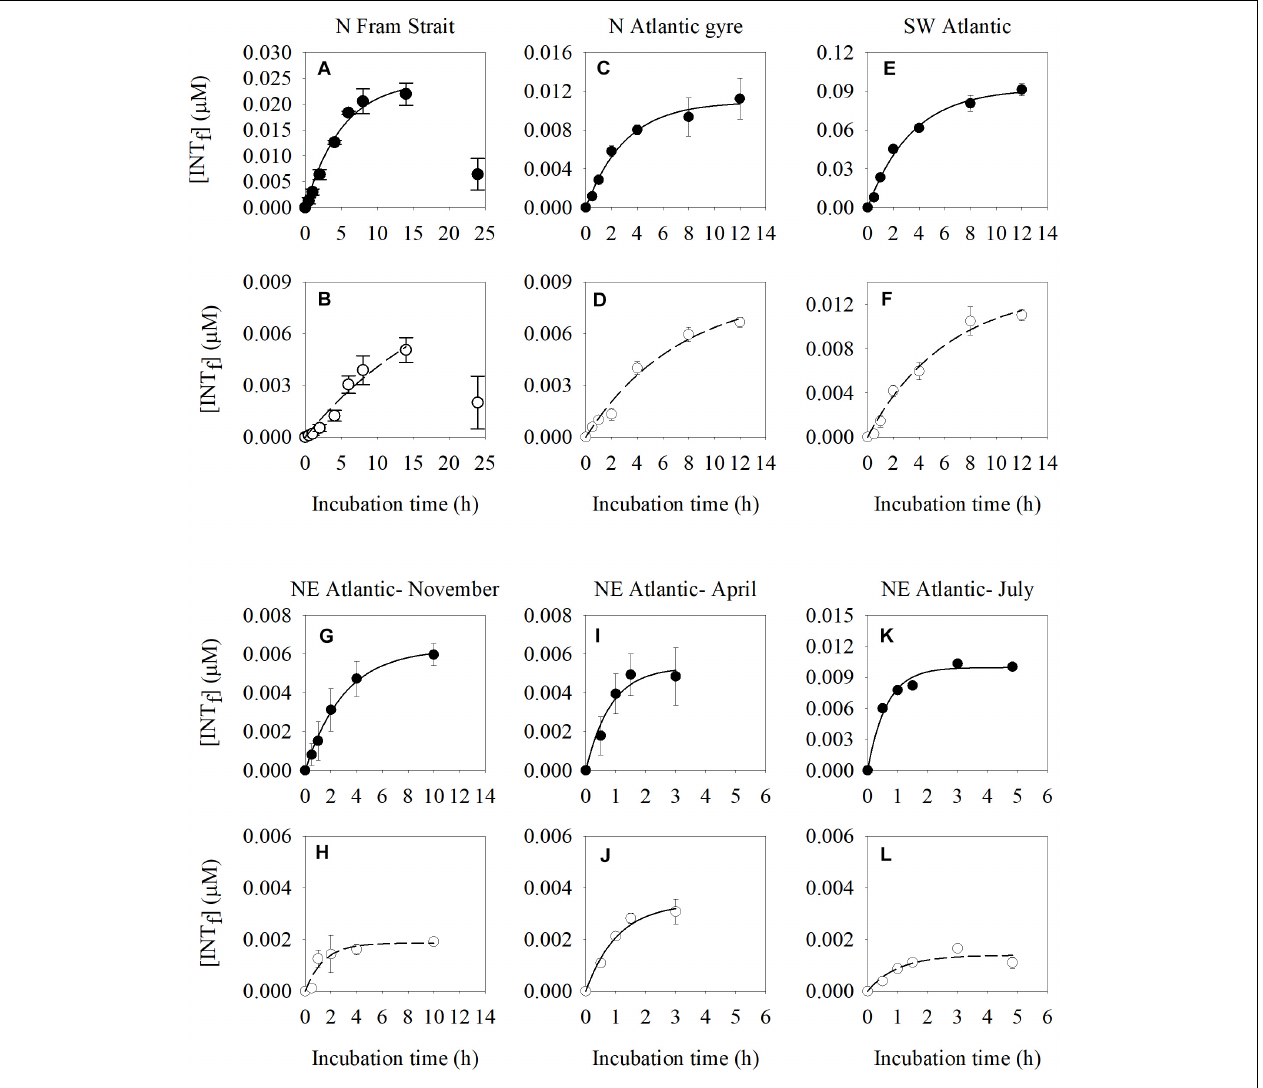
FIGURE 2 | Time course changes of INT formazan (INT f ) concentration ( µ M) produced by the reduction of INT of natural plankton communities estimated in two different size fractions: the > 0.8 µ m size-fraction (solid dots) (A,C,E,G,I,K) and 0.2–0.8 µ m size fraction (white dots) (B,D,F,H,J,L) at different locations (North Fram Strait, N Atlantic subtropical gyre, SW Atlantic, NE Atlantic Shelf Sea in November, April, and July). The error bars represent the standard error of the formazan concentration. Final INT concentration in all time course experiments is 0.2